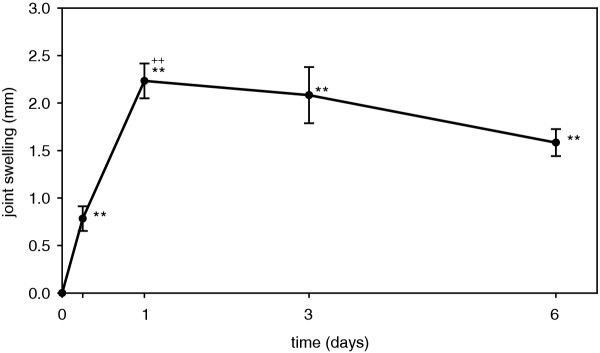
Time course of knee-joint swelling in rats with AIA used to evaluate cytokine mRNA. Values are means (n = 4 to 6); vertical bars indicate the standard error of the mean. The disease is characterized by rapid onset of acute inflammation, a peak on day 1, and a transition to chronicity on day 6. **P ≤ 0.01 in comparison with day 0; ++P ≤ 0.01 in comparison with the preceding date. AIA, antigen-induced arthritis.